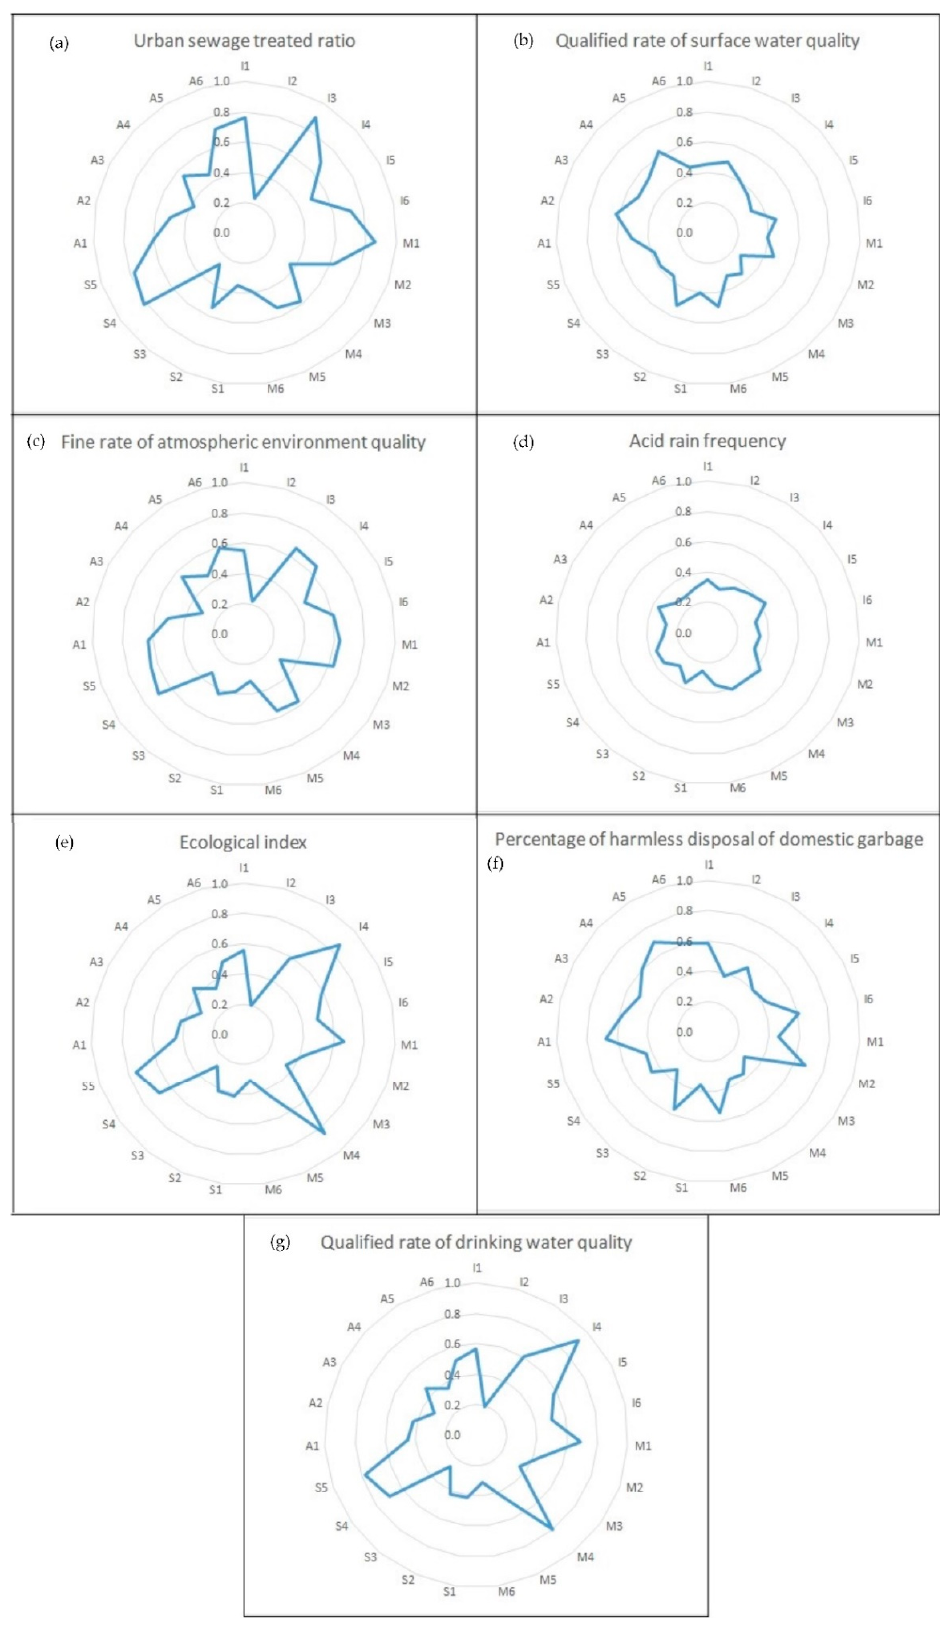
Figure 5. Contribution degree of QI attribute indices to (a) urban sewage treated ratio; (b) qualified rate of surface water quality; (c) fine rate of atmospheric environment quality; (d) acid rain frequency; (e) ecological index; (f) percentage of harmless disposal of domestic garbage; (g) qualified rate of drinking water quality in Jiangsu.